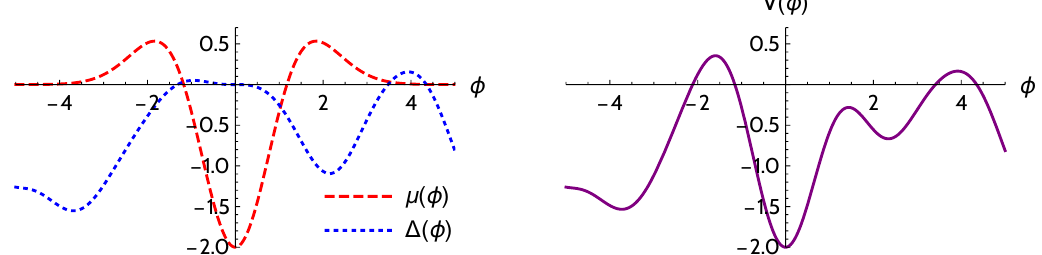
Figure 1. A 1d example of a Slepian model of a constrained minimum in a GRF. We show, for a particular realization, the two separate components of the construction on the left, namely, the constrained mean (cid:12)eld form (cid:22) ( (cid:30) ) in eq. (3.7) and the inhomogenous new GRF (cid:1)( (cid:30) ) with covariance function given by eq. (3.8). The total GRF is shown on the